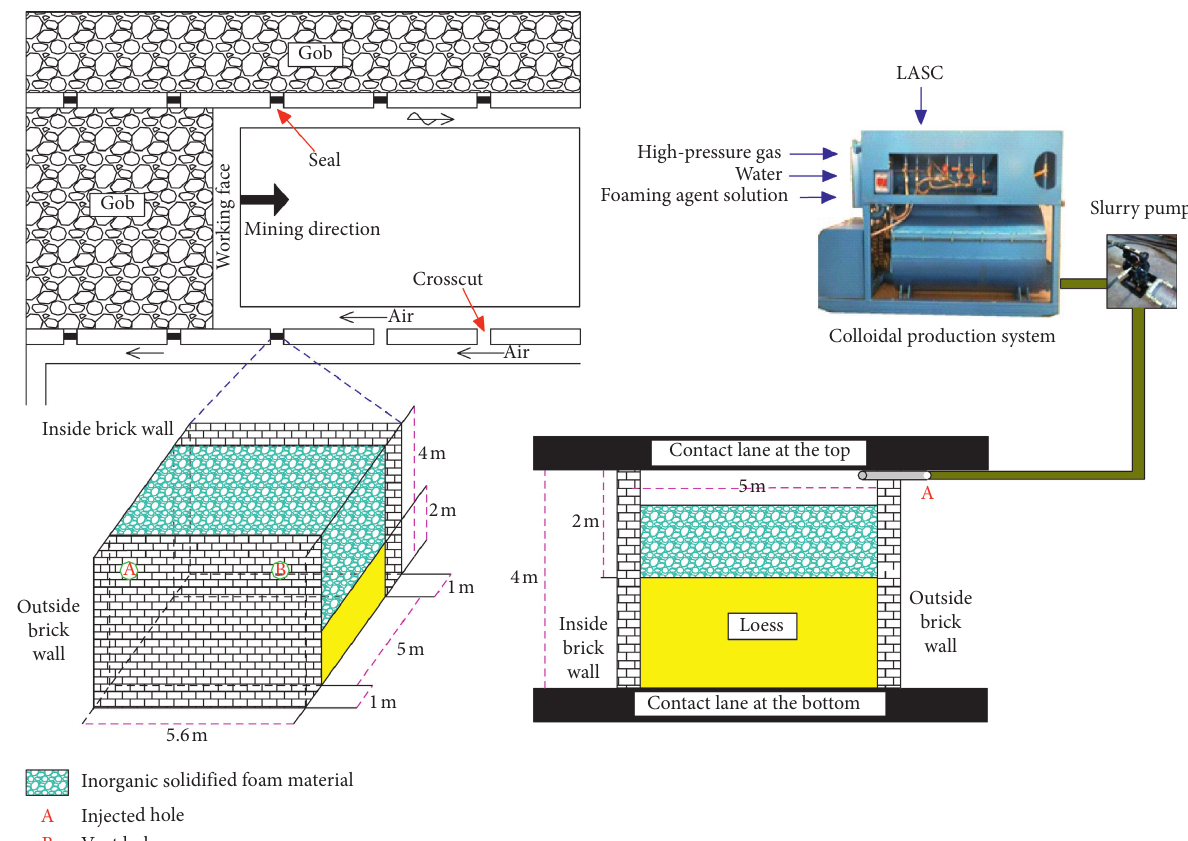
Figure 15: Schematic diagram of LASC curing foam cement filling process.